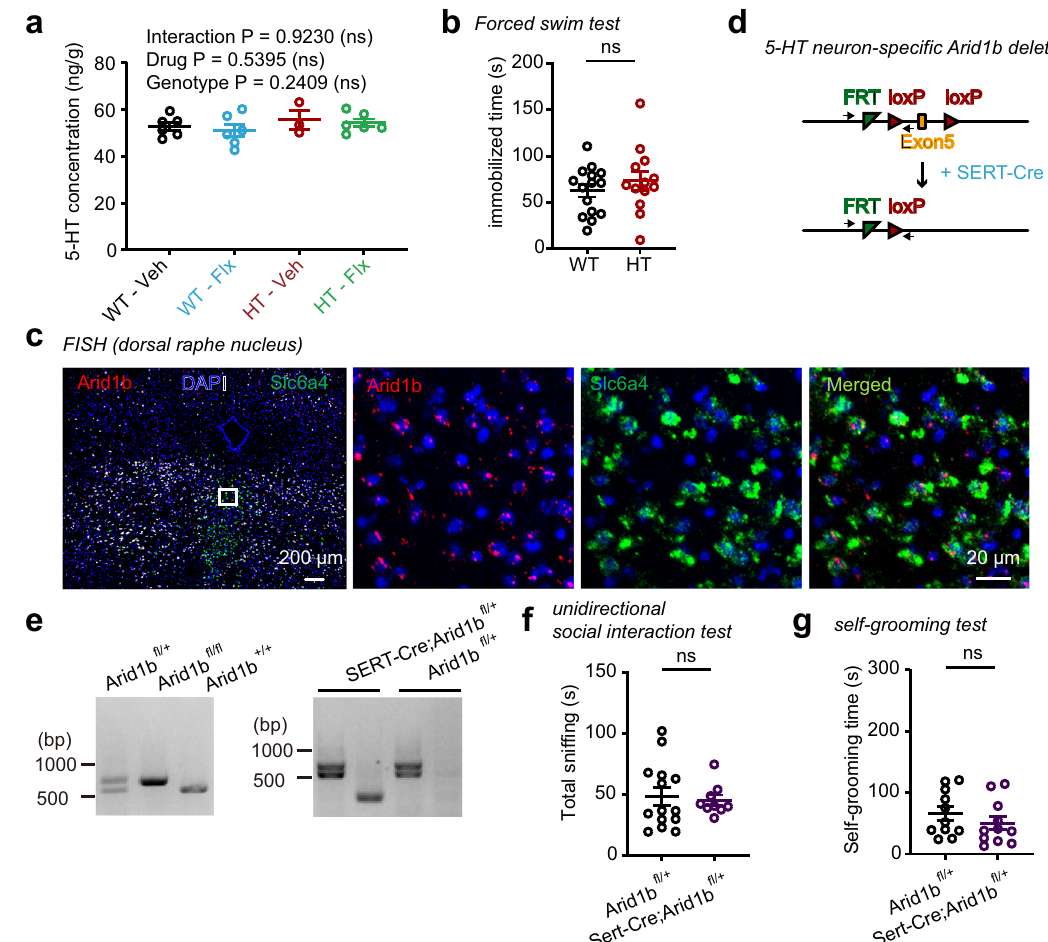
Fig. 8 | Brain 5-HT levels and serotonergic neuronal Arid1b expression mini- mally affect Arid1b +/ – phenotypes. a Comparable 5-HT concentrations in whole brains of vehicle- or fl uoxetine-treated (P3 – 10) WT and Arid1b +/ – mice, determined at P10 by LC-MS/MS. ( n =6 mice [WT-Veh], 3 [HT-Veh], 6 [WT-Flx], 6 [HT-Flx], two- way ANOVA). b Comparable levels of depression-like behavior in adult (P80) WT and Arid1b +/ – mice, as indicated by immobile time in the forced-swim test. ( n =15 mice [WT], 13 [HT], two-tailed Student ’ s t-test, [ p =0.3632]). c Fluorescence in situ hybridization(FISH)showingexpressionof Arid1b inserotonergicneuronspositive for Slc6a4 , encoding the serotonintransporterSERT. Similar results wereobtained from two independent experiments. d Schema for the generation of mice with conditionaldeletionofexon5ofthe Arid1b